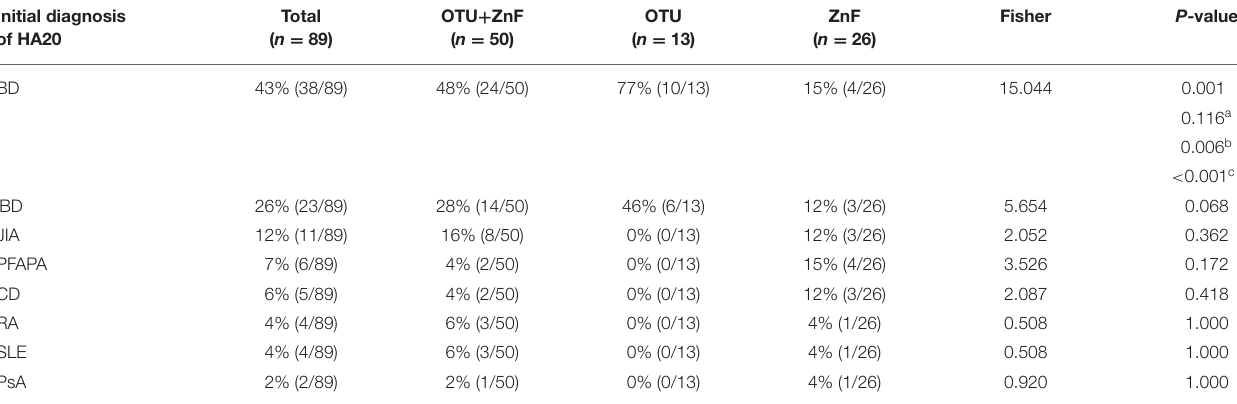
TABLE 2 | Univariate analysis of initial diagnosis in HA20 patients based on types of A20 disruption. Initial diagnosis of HA20